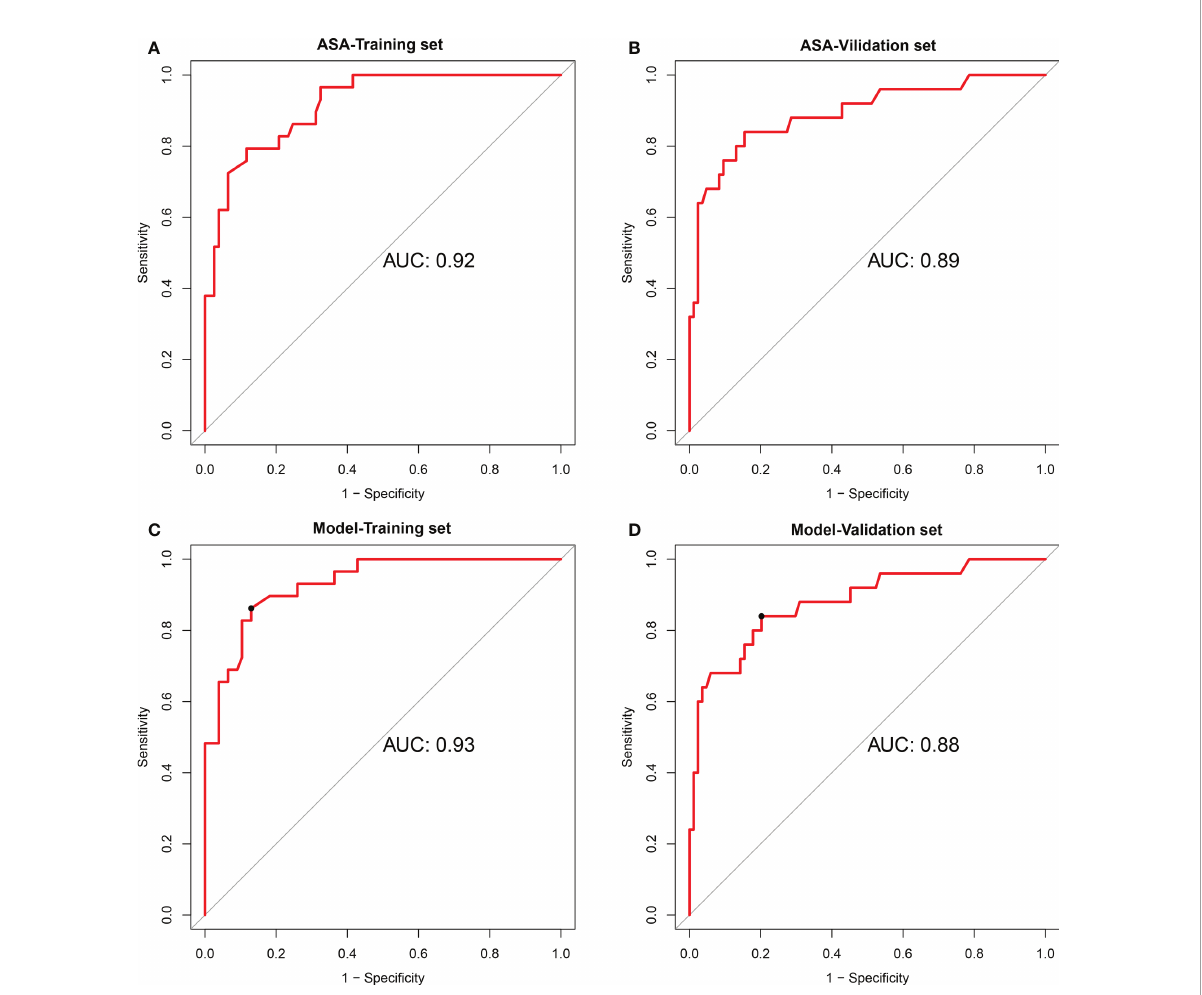
FIGURE 2 Performances of the degree of encasement of the carotid artery and the prediction model in the training cohort and validation cohort. (A, B) degree of encasement of vascular structure (axial surrounding angle), (C, D) Prediction model, including vascular deformation and the degree of encasement of the carotid artery. ASA, axial surrounding